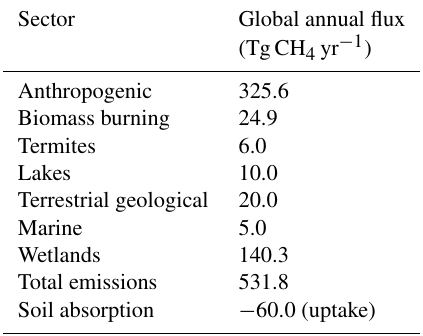
Table 2. Global methane emissions and soil sink for